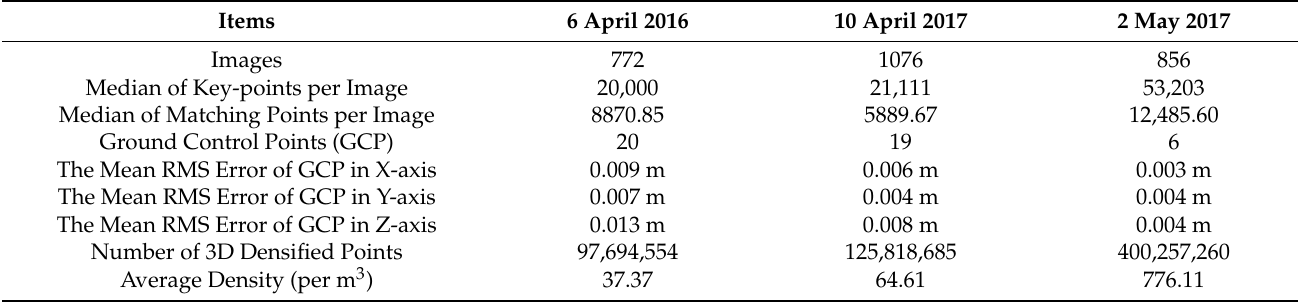
Table 1. The information from the quality report of each UAV flight missions.